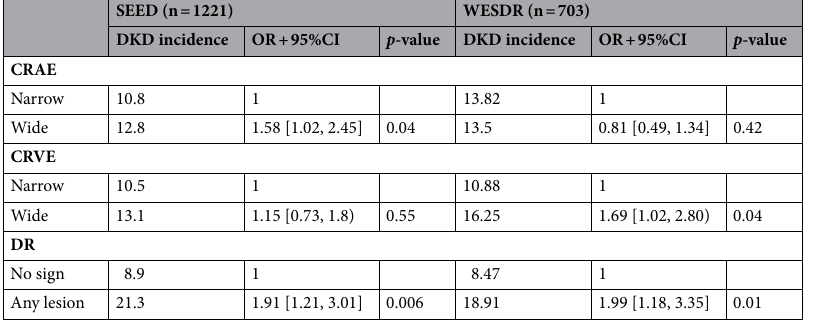
Table 2. Associations between vascular calibers and the incidence of diabetic kidney disease (DKD) according to the DR status using multivariable logistic model in SEED and WESDR cohorts. Central retinal arteriolar equivalent (CRAE) and central retinal venular equivalent (CRVE) were considered narrow if ≤ median value and wide if > median value. The models were adjusted for age, gender, education, BMI, smoking status, systolic blood pressure, blood glycosylated haemoglobin, duration of diabetes, hypertensive treatment and history of cardiovascular events (with further adjustment on ethnicity, baseline level of eGFR and total cholesterol in SEED).